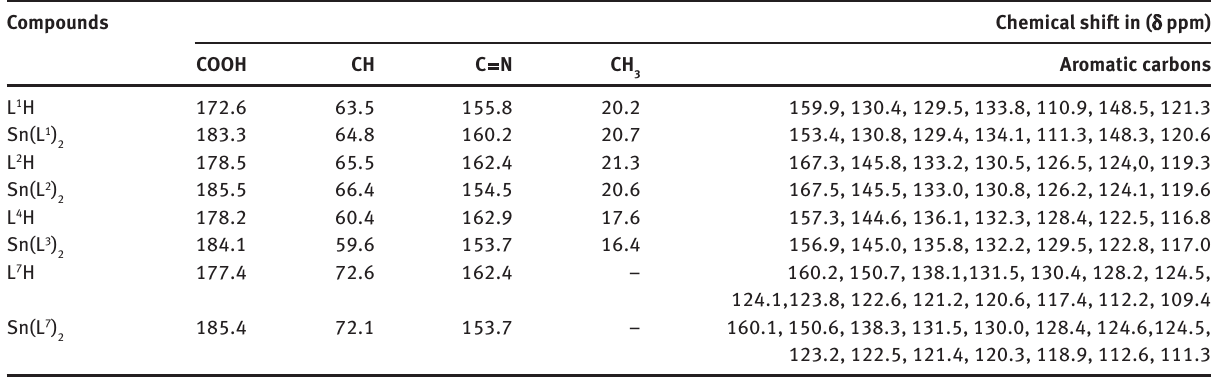
Table 4: 13 C NMR spectral data of the ligands and their corresponding tin(II) complexes. Compounds Chemical shift in ( δ ppm)